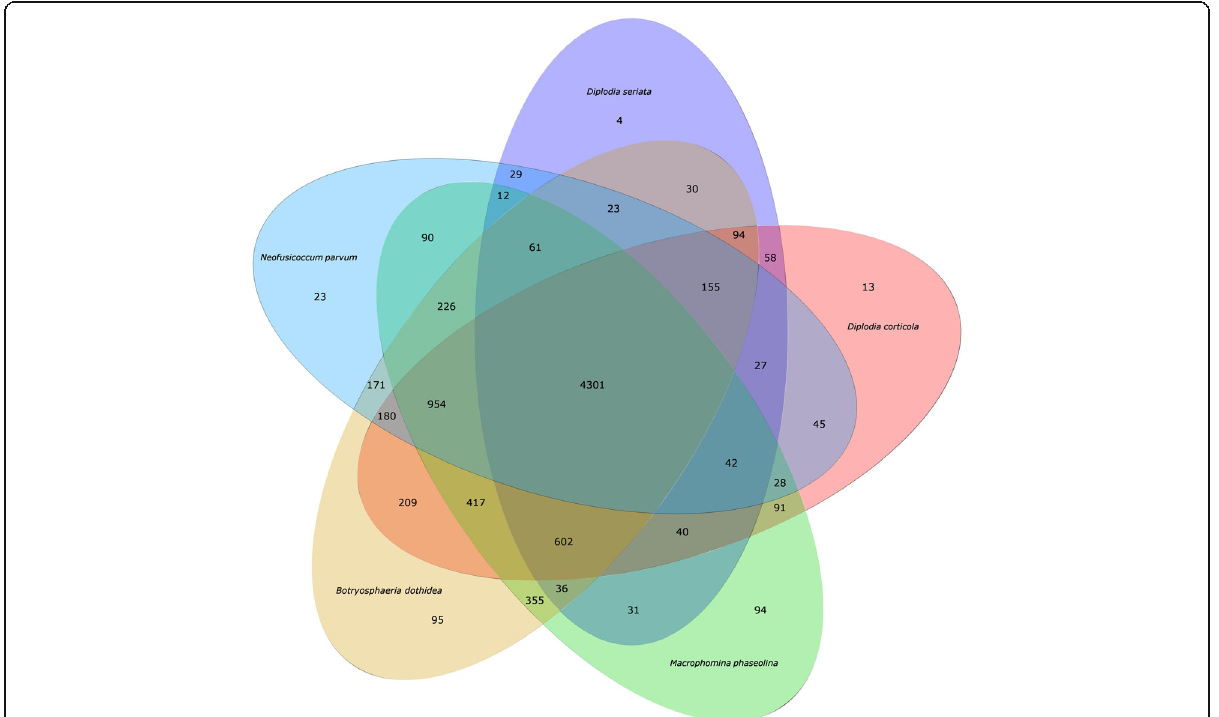
Fig. 6 Venn diagram of predicted Botryosphaeria dothidea LW-Hubei gene families by comparison with four Botryosphaeriaceae species . The five fungi are represented by different colors: B. dothidea LW-Hubei strain, light pink; Macrophomina phaseolina , green; Neofusicoccum parvum , light blue; Diplodia corticola , pink and Diplodia seriata ,